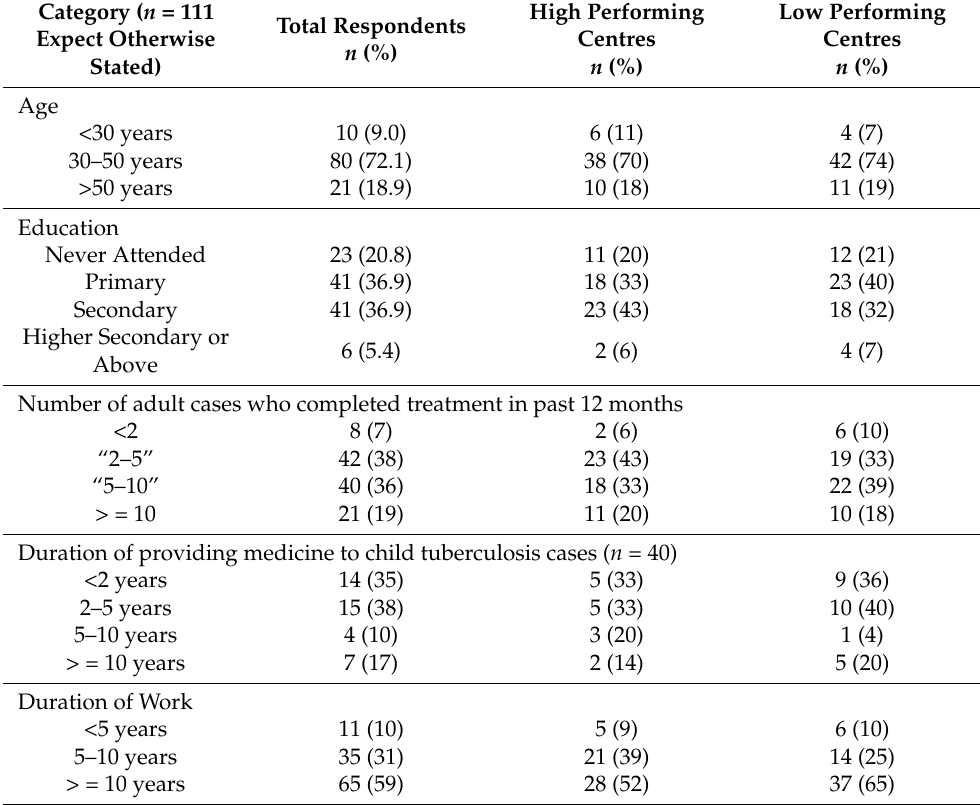
Table 3. Demographic